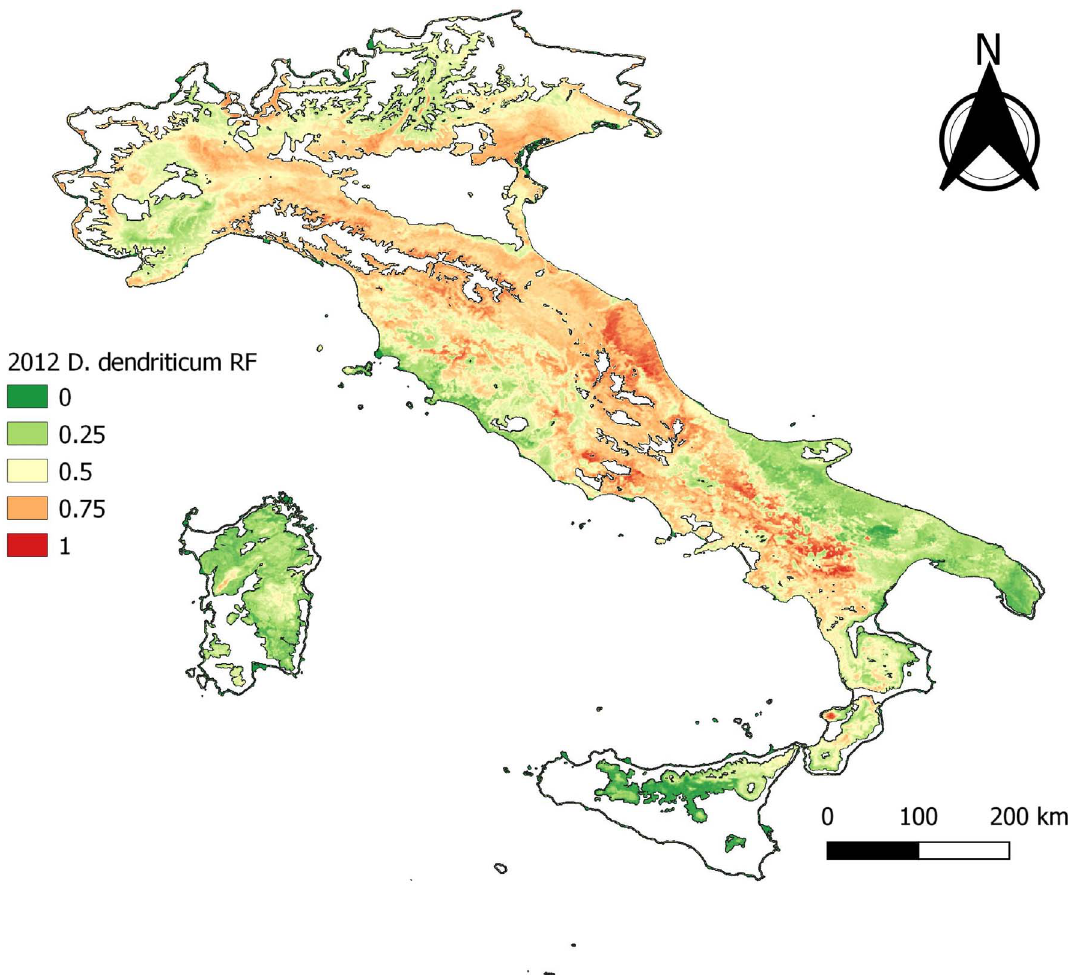
Figure 7. Annual distribution model